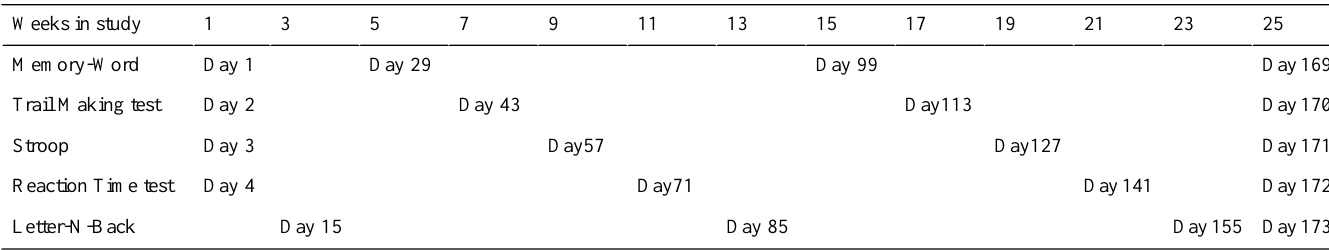
Table 1. Message moment per cognitive test during follow-up. 252321191715131197531Weeks in